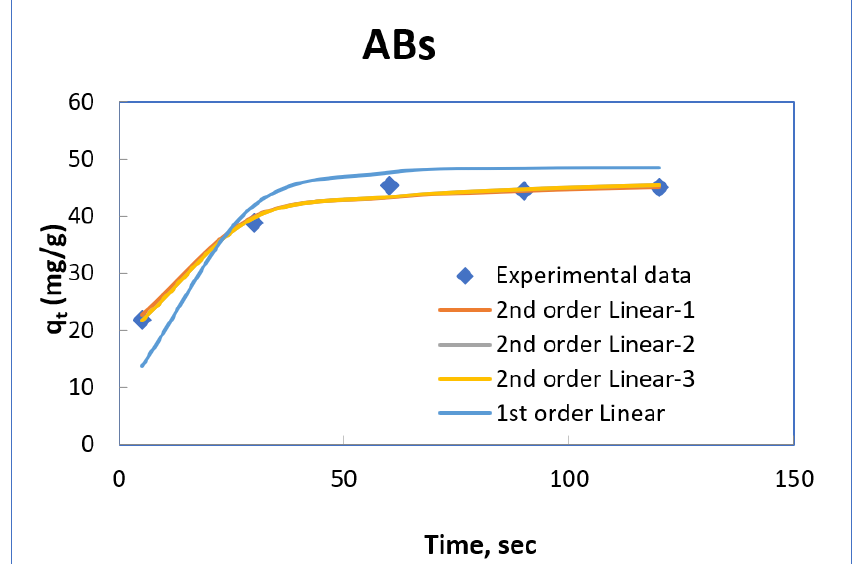
Figure 19. The nonlinear and linearized form of first and second-order kinetics model for adsorption